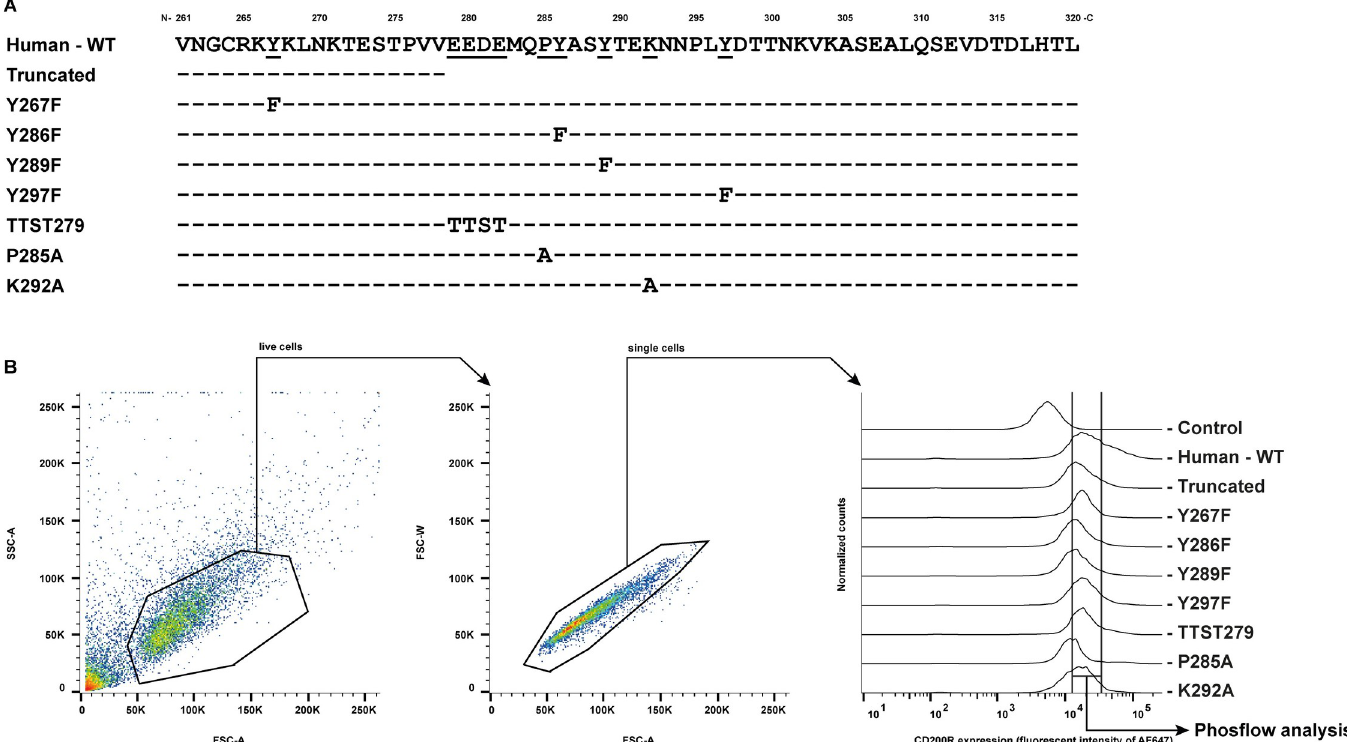
Fig 3. U937-CD200R mutants express CD200R on their surface. A) Conserved residues of CD200R in mammals were mutated as indicated. B) U937 cells were transduced with different CD200R mutants and tested for their CD200R surface expression by flow cytometry. Representative figures of the gating strategy are shown. First the population of live cells was selected. From these live cells, single cells were selected and from these single cells CD200R expressing cells were selected for phosflow analysis. SSC-A: side scatter area; FSC-A: forward scatter area; FSC-W: forward scatter width. Control: staining with the secondary antibody only.